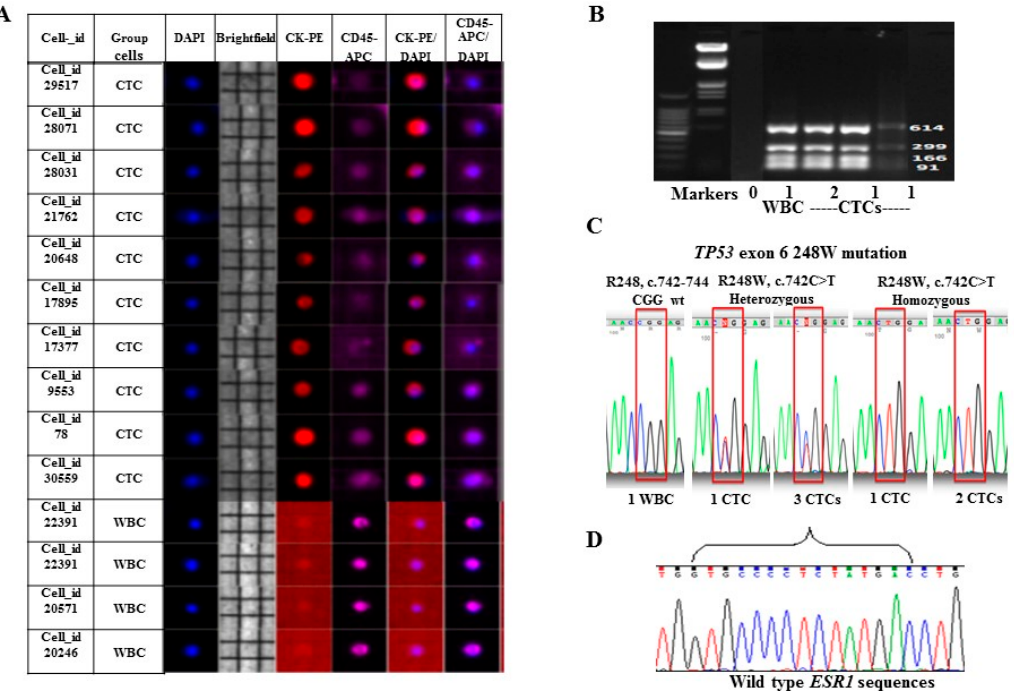
Figure 3. Genomic characterization of isolated CTCs. ( A ) Composite images visualized on the DEPArray™ platform after ScreenCell Cyto enrichment showing single CTCs (CK-PE + /DAPI + ) and WBCs (CD45-APC + /DAPI + ); ( B ) Gel images of Ampli1 quality control (QC) PCR products from CTCs and WBC showing the genome integrity with the presence of short, medium and long DNA fragments; ( C ) The TP53 exon 6 R248W mutations were detected in single CTCs and pools of CTCs, wild-type sequences in single WBC; ( D ) Wild-type ESR1 sequences were detected in all isolated CTCs.